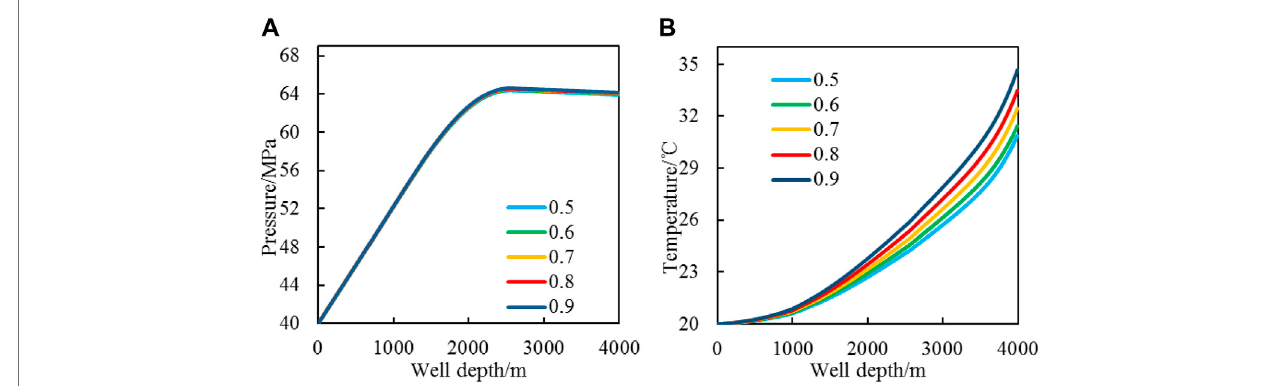
FIGURE 8 | CO 2 foam fracturing fl uid pressure and temperature change with foam quality [ (A) : pressure pro fi le; (B) : temperature pro fi le].